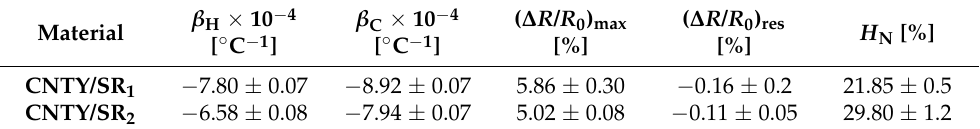
Table 4. Cyclic thermoresistive parameters of: (a) CNTY/SR 1 ; (b) CNTY/SR 2 .